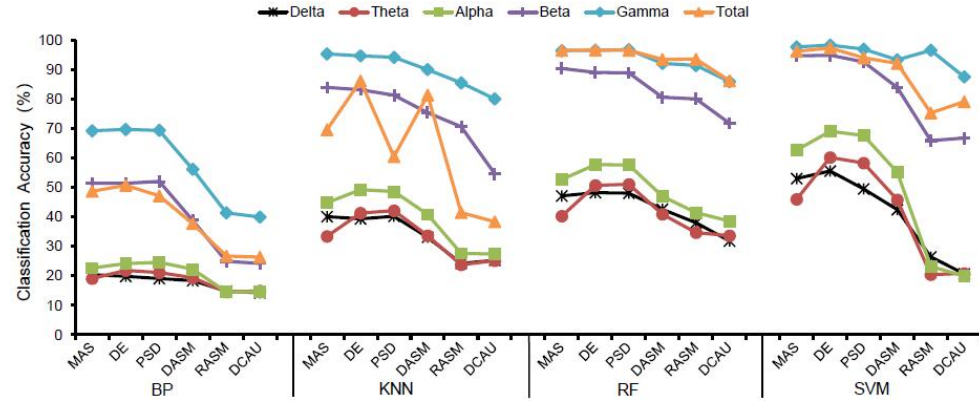
Figure 6. Classification accuracy of different EEG features.